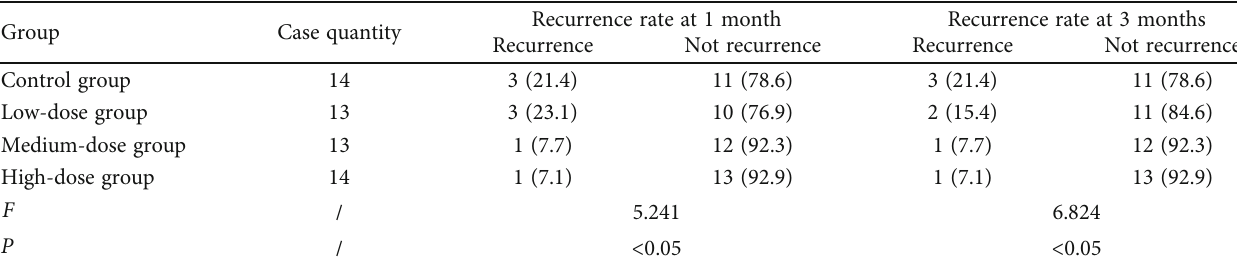
Table 2: Comparison of the recurrence rates of the four groups at 1 month and 3 months.